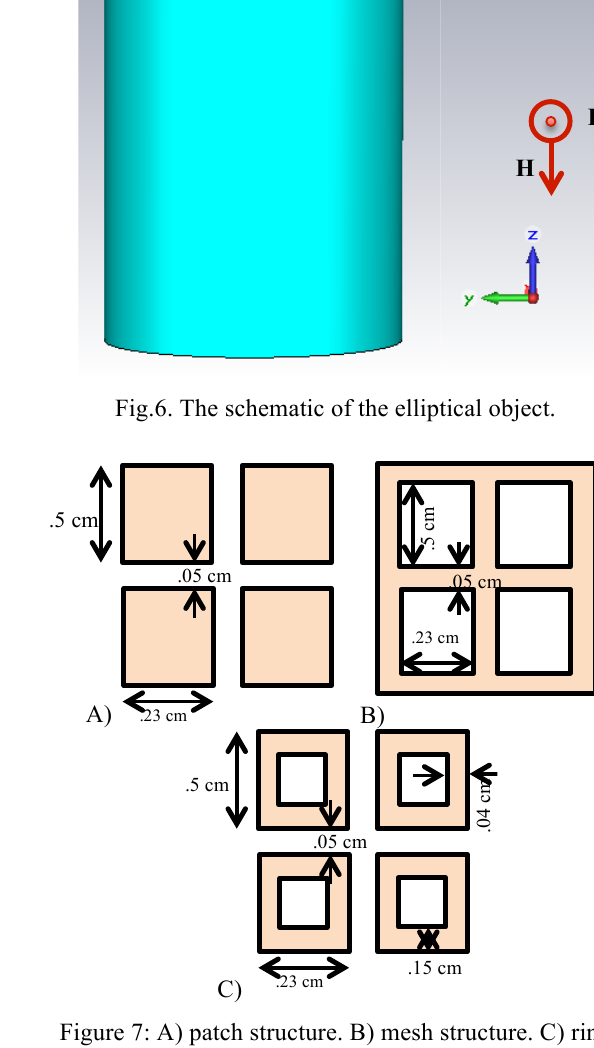
Figure 5: scattering width versus frequency the red line refers to dielectric object without cloak and blue line refers to dielectric with cloak.